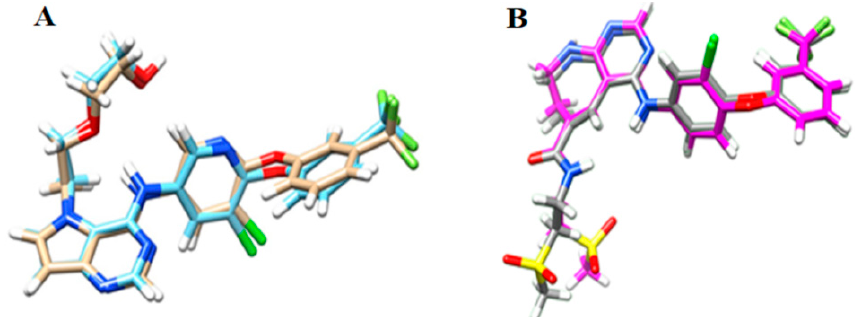
Figure 1. Redocking results for: ( A ) HER-2; and ( B ) EGFR. RMSD value for HER-2 = 0.464 Å and RMSD value for EGFR = 1.213 Å.